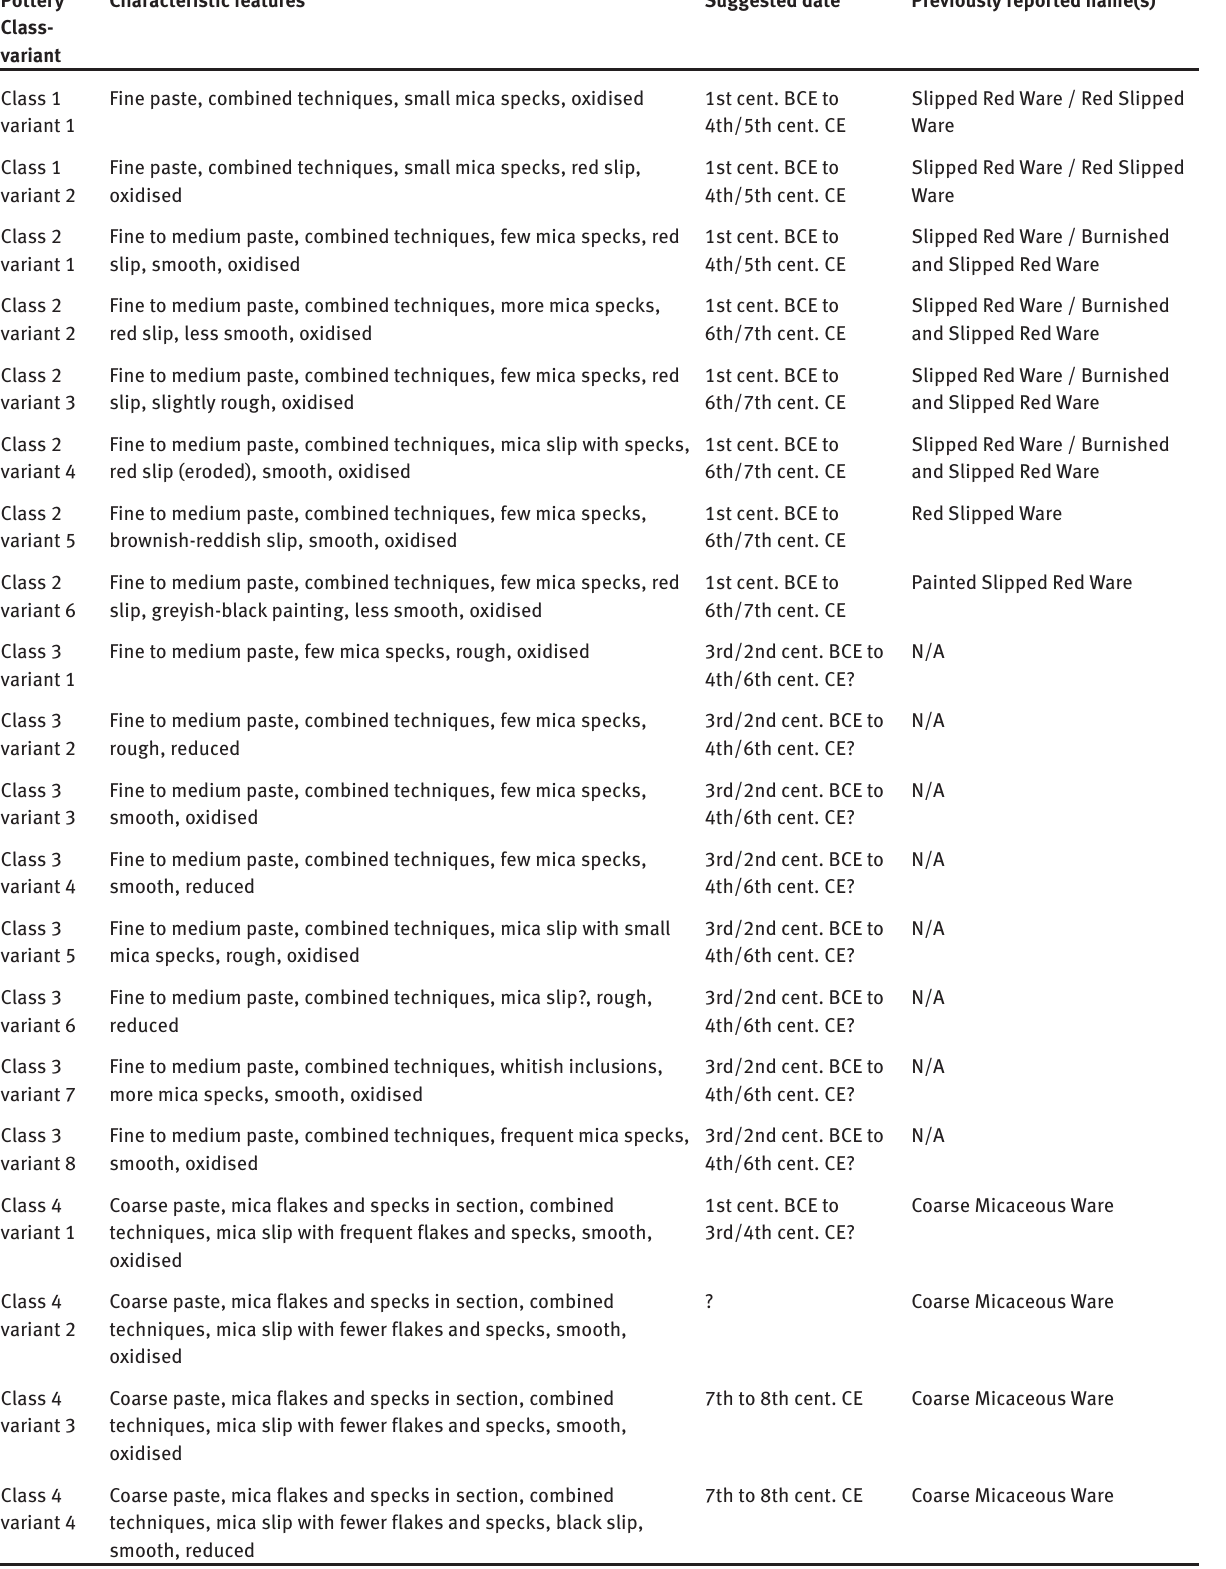
Table 2: Suggested dates and review of main characteristic features of all Class-variants identified in this study. Pottery Characteristic features Suggested date Previously reported Class- variant